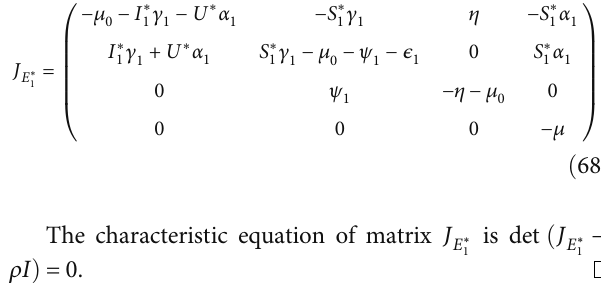
Figure 30: The impact of α